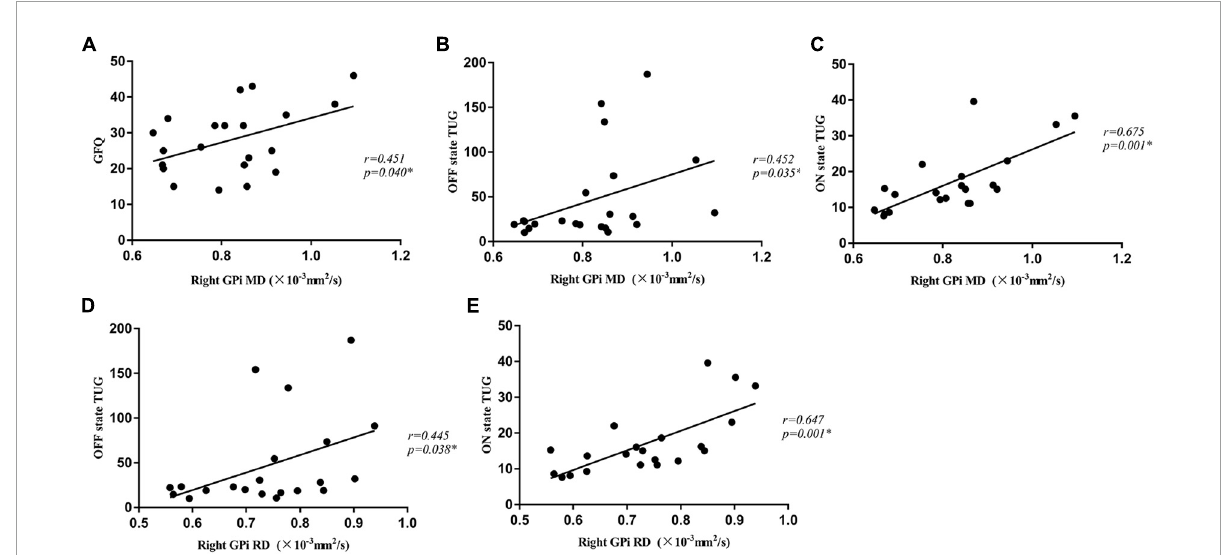
FIGURE2 The MD value of the right GPi was positively correlated with GFQ scores (A) , times of OFF state TUG (B) , and times of ON state TUG (C) in the PD-FOG group. The RD value of the right GPi was positively correlated with times of OFF state TUG (D) and ON state TUG (E) in the PD-FOG group. MD, Mean Diffusivity; RD, radial diffusivity; GFQ, Gait and Falling Questionnaire; TUG, Timed Up and Go tests; GPi, globus pallidus